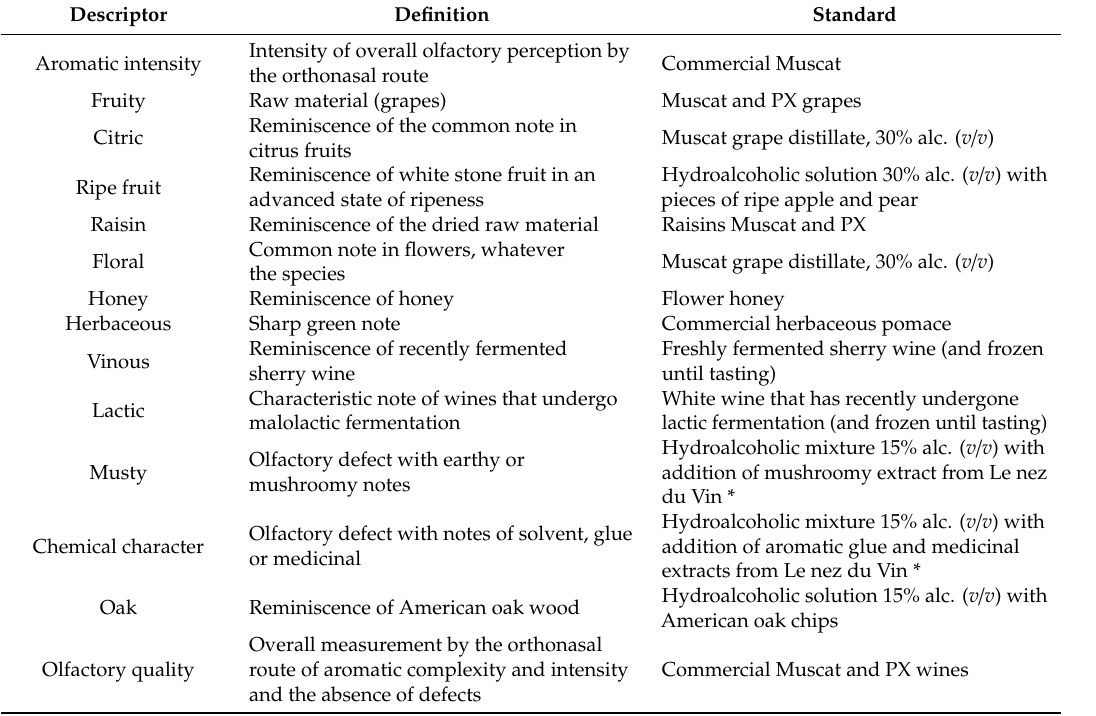
Table 2. Aroma descriptors used for sample